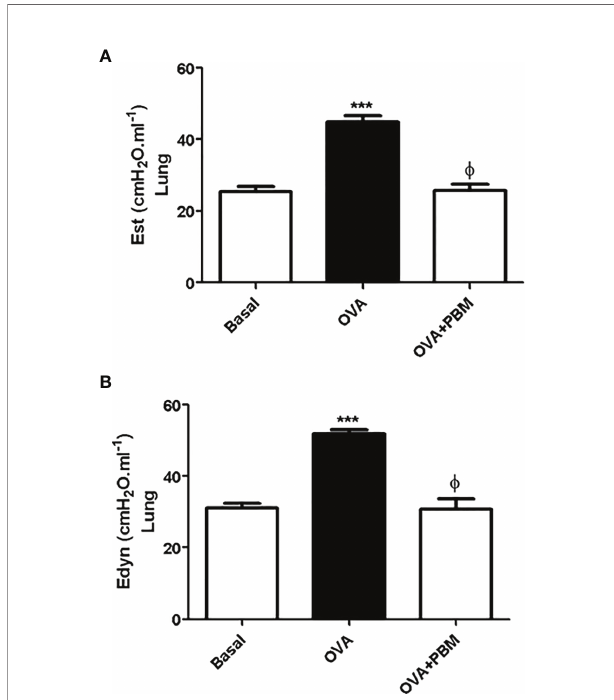
FIGURE 6 | Effect of treatment of photobiomodulation on static (A) and dynamic (B) elastance in the lung (open chest). Basal group, n = 5; OVA group, n = 7; PBM group, n = 5; OVA+ PBM, n = 8. Two independent sets of experiments were carried out. Data are expressed as mean±SEM. *** p < 0.001 in relation to the Basal group; f p < 0.001 in relation to the OVA